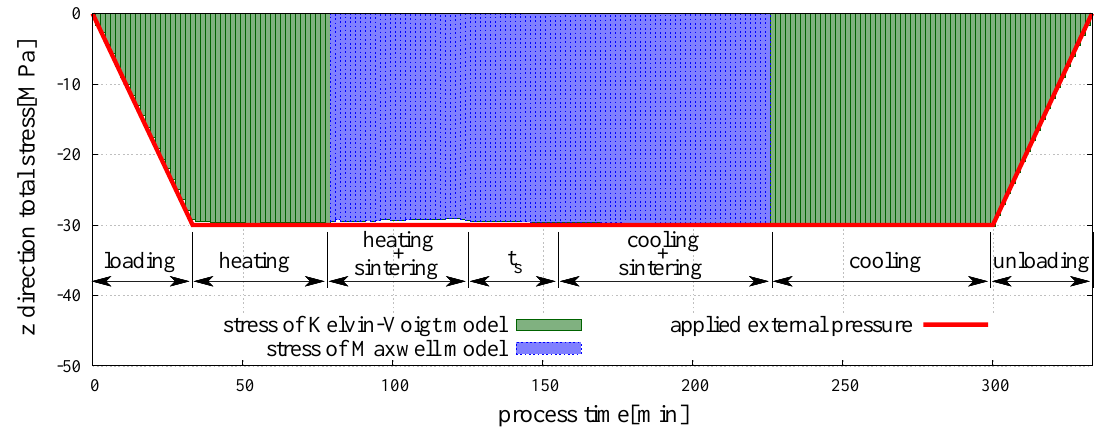
Figure 7. Evolution of total macroscopic stress of the hot pressing process in z